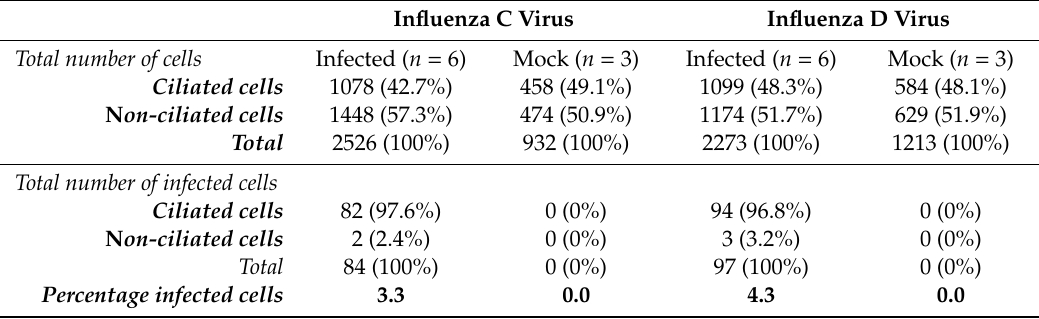
Table 3. Summary of the total number of cells counted in ICV- and IDV-infected hAEC